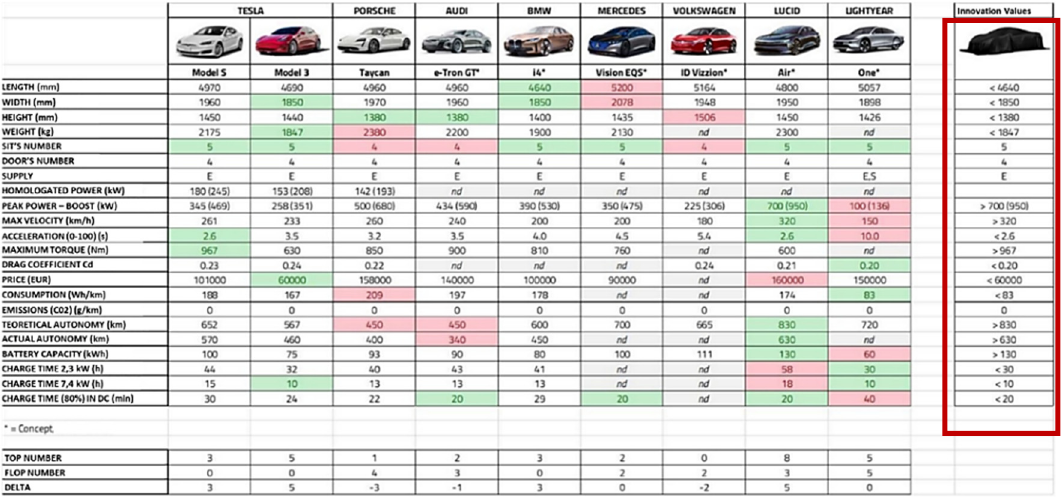
Figure 3. Innovation value per each competitor’s car models.